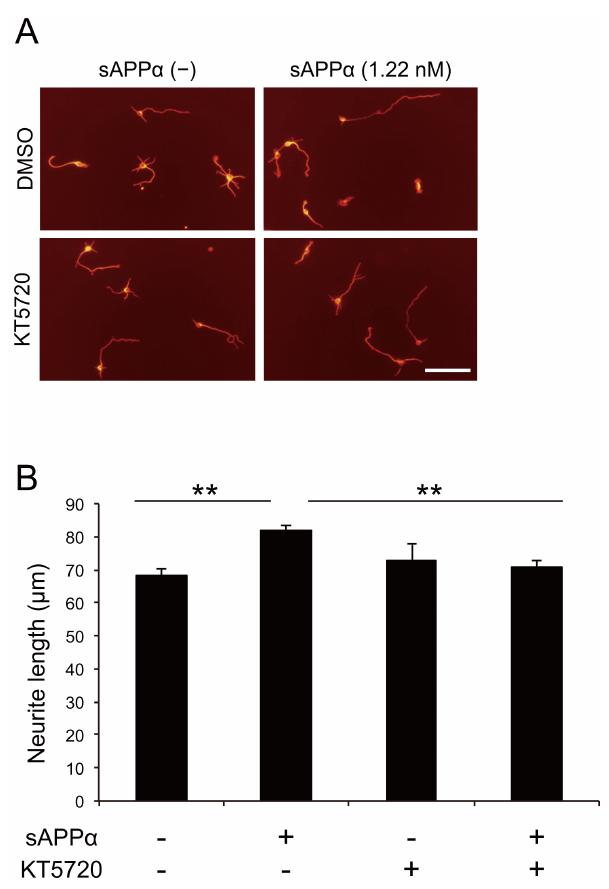
Figure 5. PKA is required for sAPP a -induced neurite out- growth. (A, B) Inhibition of PKA abolished the sAPP a -induced neurite outgrowth. Neurons were cultured with sAPP a and/or PKA inhibitor, KT5720 for 24 h. (A) The representative images of cortical neurons are shown. Scale bar: 100 m m. (B) The mean lengths of the longest neurite per neuron were measured by image J software and represented in the graph. The graph showed the means 6 SEM of three independent experiments. The number of neurons was 150 for each experiment. ** p , 0.01, Tukey-Kramer test.